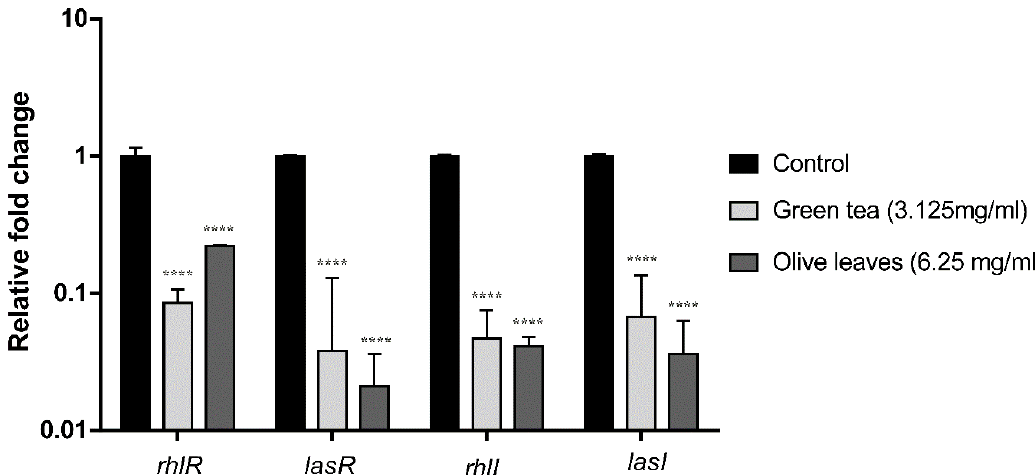
Figure 5. Effect of Camellia sinensis and Olea europaea extracts on the expression of QS-regulated genes of P. aeruginosa (E81). Bar chart of the qRT-PCR analysis representing the relative transcription levels of lasI , lasR , rhlI , and rhlR genes treated with sub-MIC levels of Camellia sinensis (3.125 mg / mL) and Olea europaea (6.25 mg / mL), normalized with the reference gene 5s RNA and compared to the untreated control. The error bars indicate the standard deviations of three replicates. **** = p < 0.0001: significance was compared to the respective